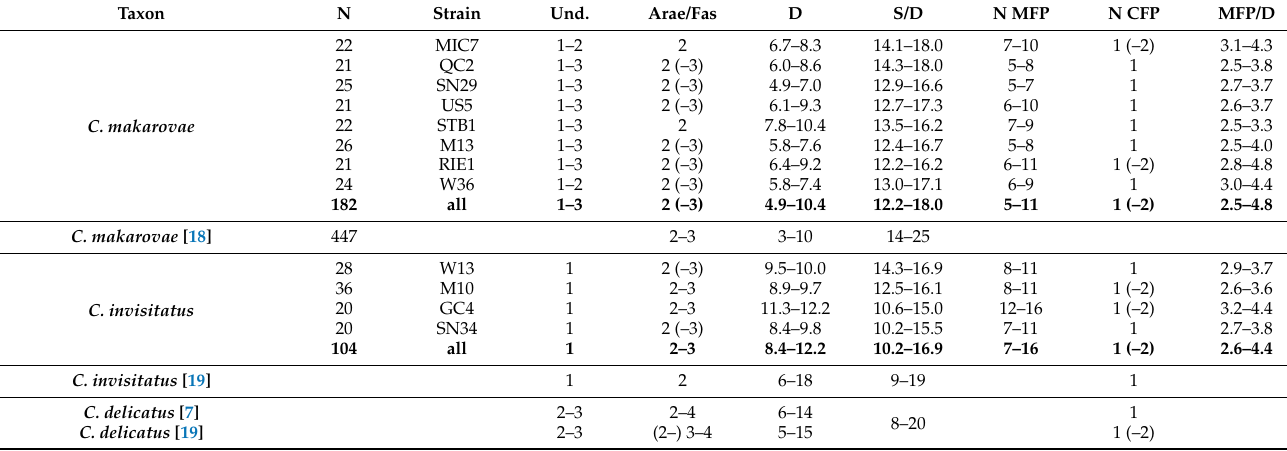
Figure 1. Concatenated gene tree of LSU D2/D3, rbc L and cox 1 sequences of the dataset strains. Strains within the blue box possess 2 satellite pores marginal to the fultoportulae. Left branch support values = BI, right branch support values = ML; BI/ML branch support values over 90/50 are displayed. Table 2. Morphometric measurements of the strains studied and summaries, compared with literature references by Genkal 2007 for C. makarovae , Houk et al. 2014 for C. invisitatus and C. delicatus and Håkansson and Kling 1990 for C. delicatus . Und = undulation (1 = flat, 2 = somewhat undulated, 3 = distinctly undulated); Arae/Fas = maximum number of rows of areolae per fascicle at the valve-mantle-junction; D = diameter in µ m; S/D = striae in 10 µ m circumference [10]; N MFP = number of marginal fultoportulae; N CFP = number central fultoportulae; MFP/D = marginal fultoportulae in 10 µ m circumference.